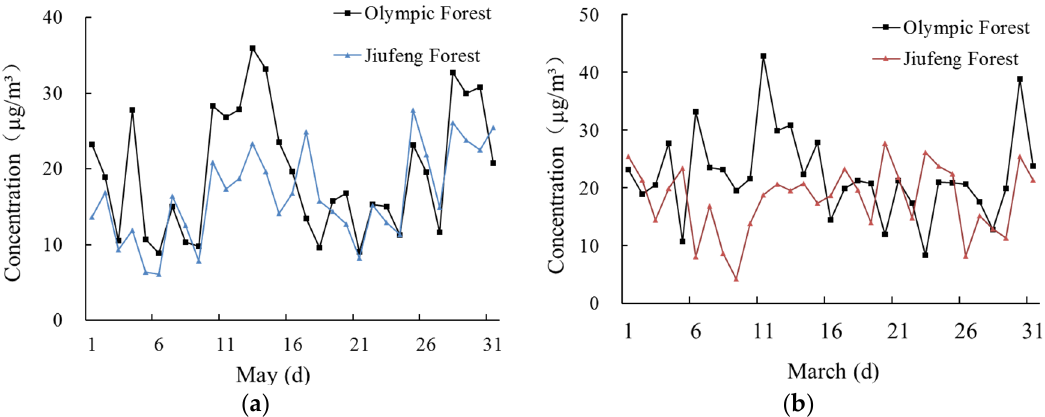
Figure 2. The daily average concentrations of SO 42 − at the height of 9 m in March and May in two sampling sites. ( a ) March 2013; ( b ) May 2013.